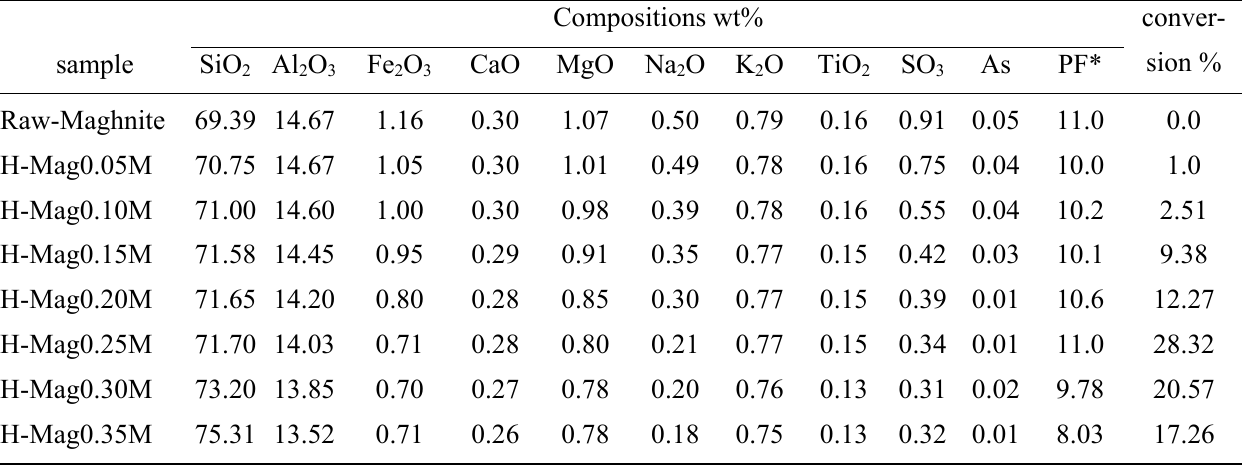
Table 1. Elementary compositions of Protons exchanged samples “H-Maghnite”